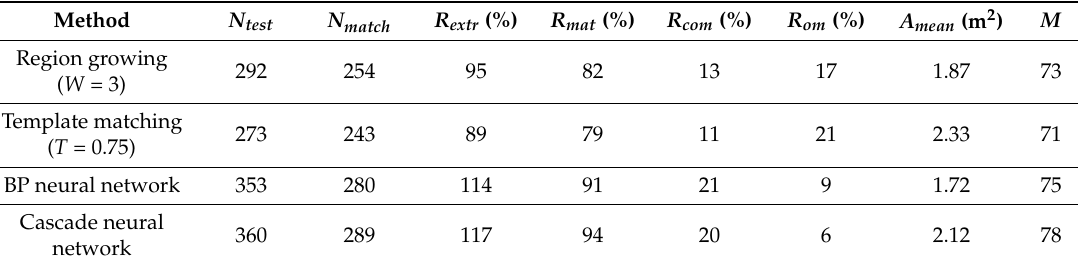
Table 2. Detection results for test area 2